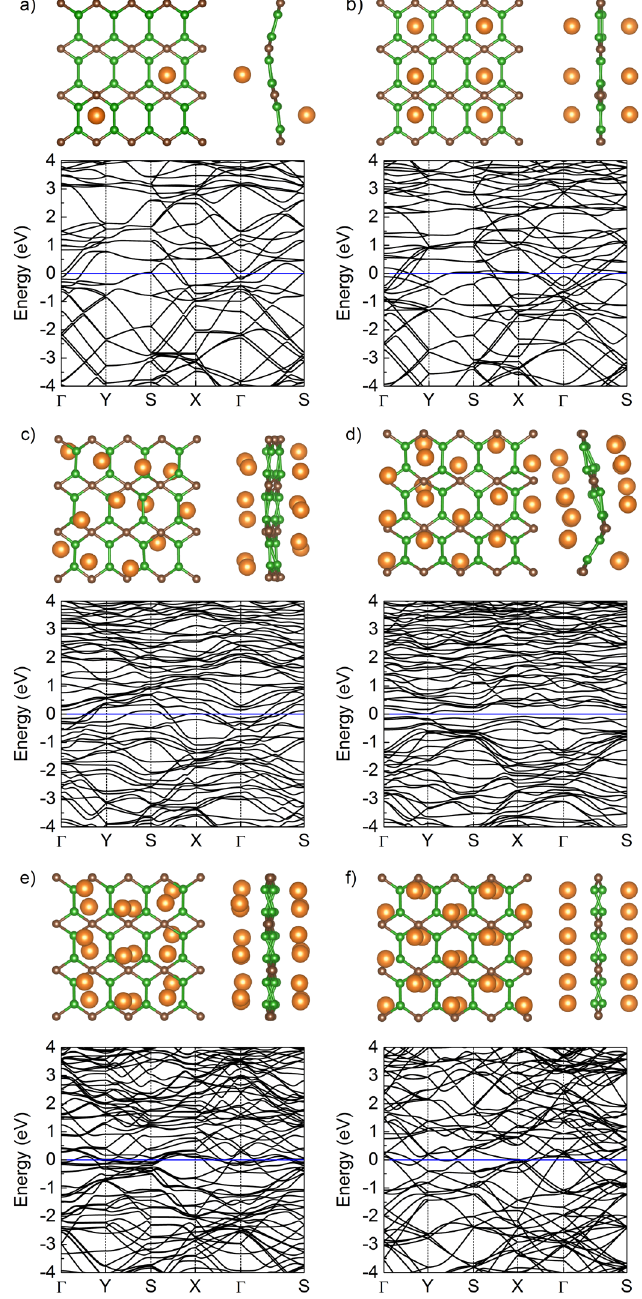
Figure 3. The top view and side view of relaxed structure of 4 × 3 supercell of B 2 C monolayer with ( a ) 2, ( b ) 6, ( c ) 12, ( d ) 16, ( e ) 18, and ( f ) 24 adsorbed Mg atoms. The corresponding electronic band structures are presented